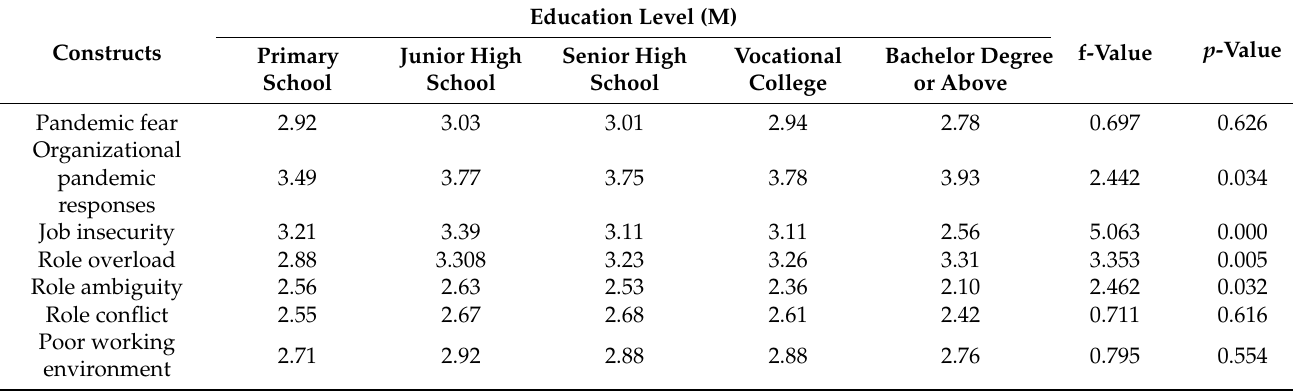
Table 8. ANOVA analysis of education